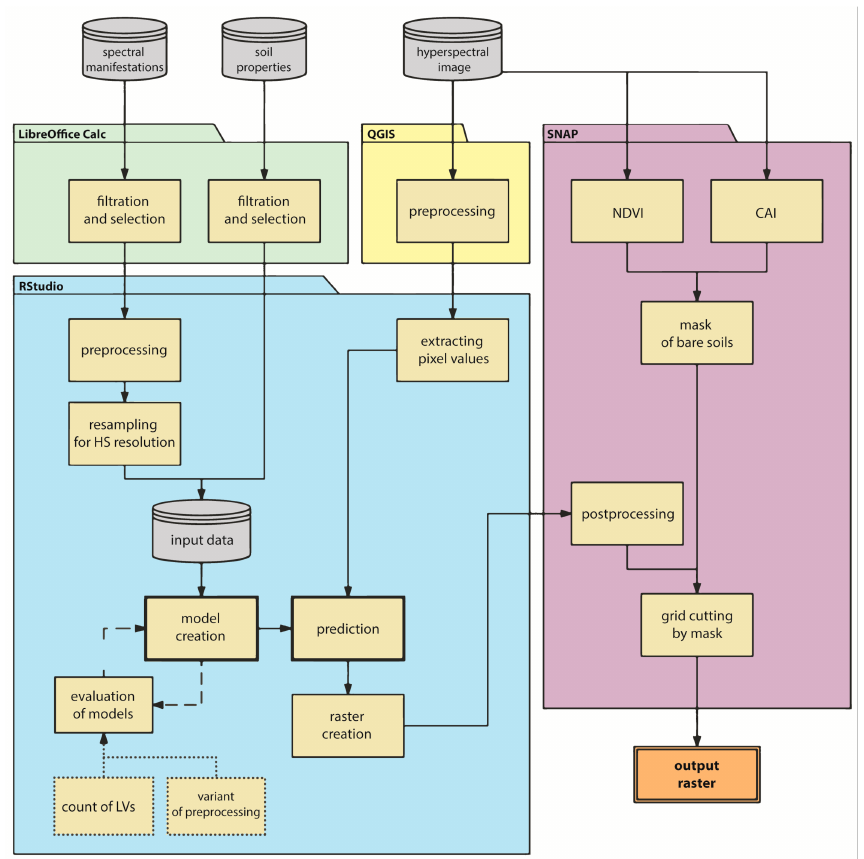
Figure 2. Schematic flowchart for predicting soil total nitrogen using PLSR method.